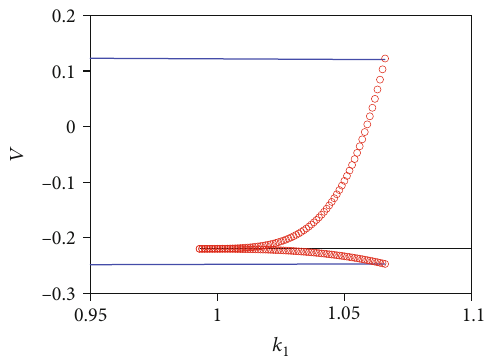
Figure 11: Bifurcation diagram as varying amplitude of feedback current from electromagnetic induction k